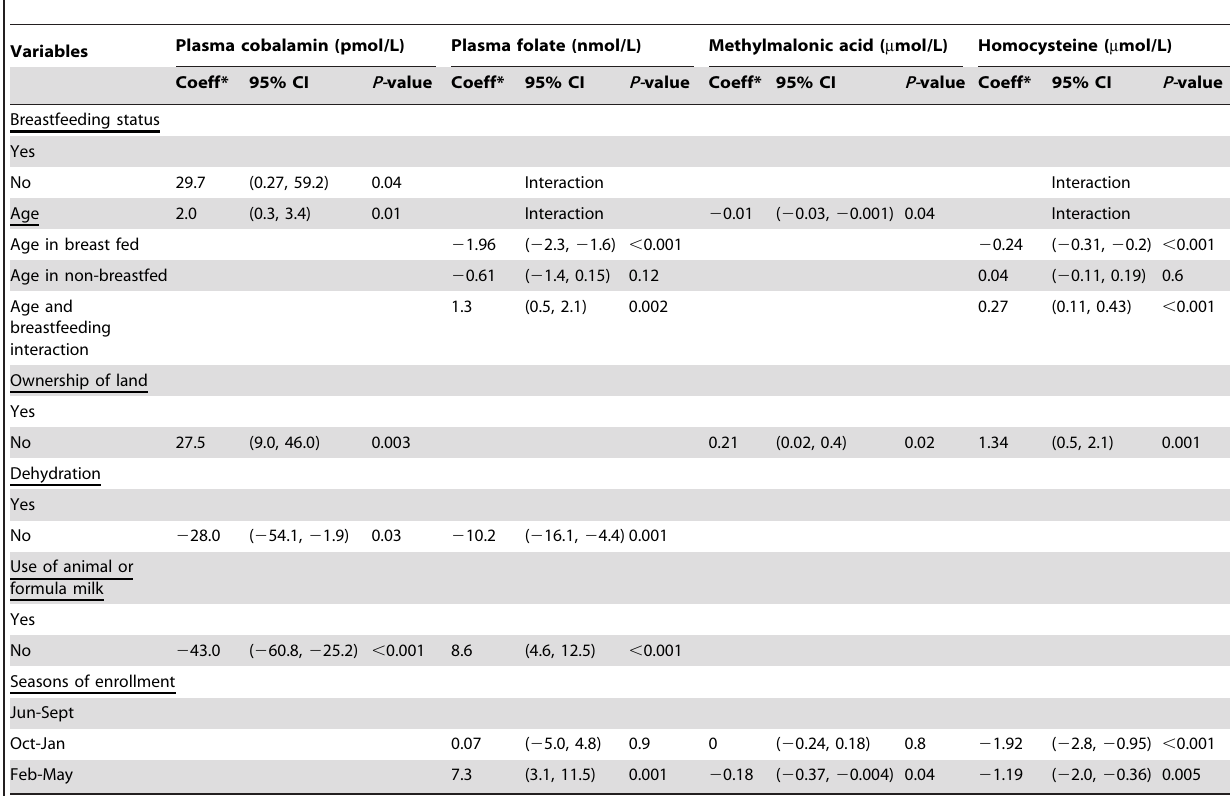
* Adjusted regression coefficient and P values obtained from linear regression model adjusted for the variables included in this table, R square values of plasma cobalamin, folate, tHcy and MMA are 0.083, 0.30, 0.15 and 0.02,